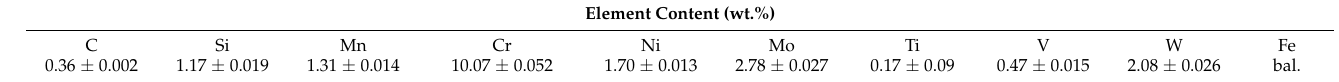
Figure 7. Exemplary SEM pictures of the microstructures at the top ( a ), mid ( b ) and bottom ( c ) of continuously processed tool steel X36 in as-built condition, showing coarsening of the microstruc- ture towards the specimen’s top ( d ) temperature measurements in the substrate during DED-Arc processing of tool steel X36. The arrow marks the build-up direction. Table 7. Average chemical composition over 120 layers of deposited tool steel X36 measured by OES. Element Content